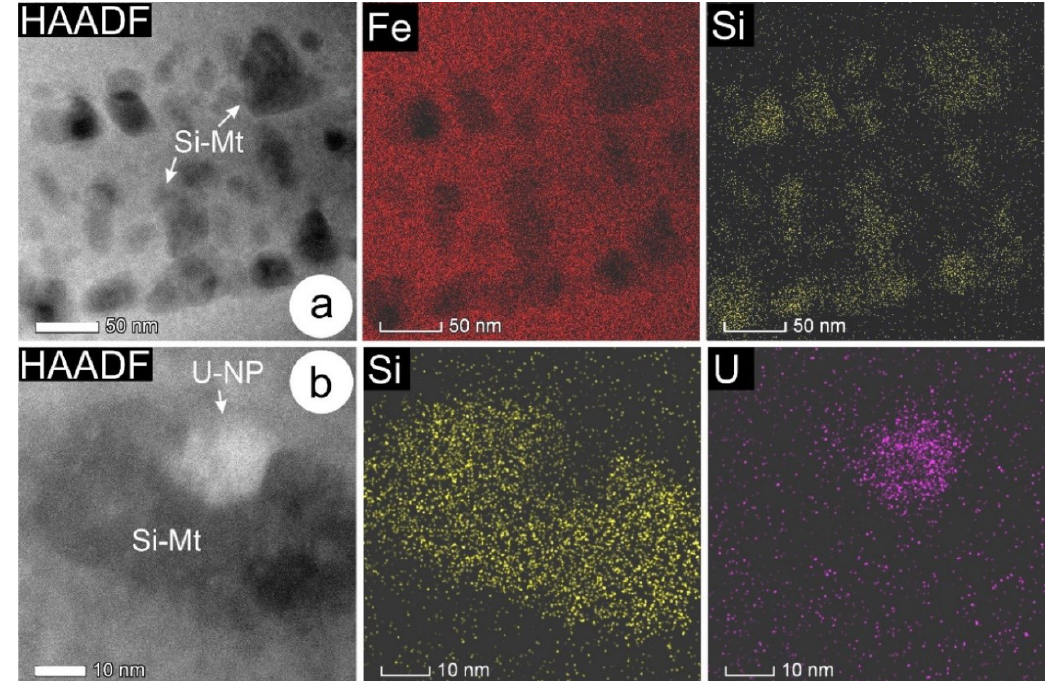
white dashed lines on the maps.